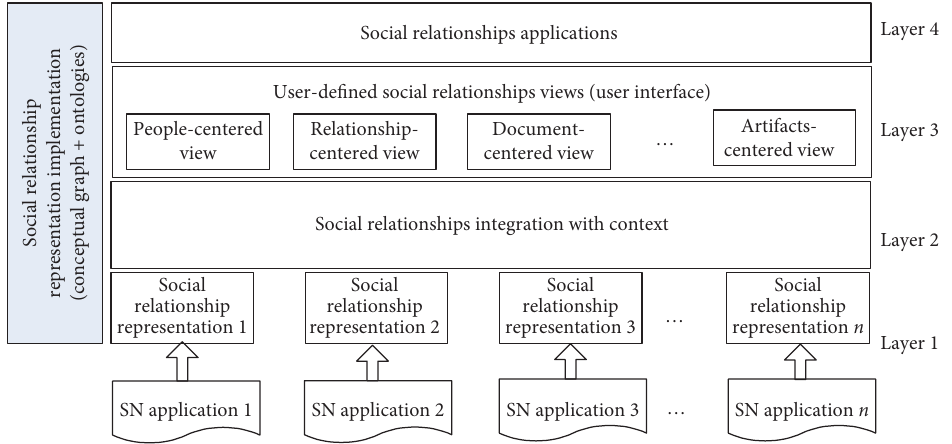
Figure 1: The proposed social relationship semantic